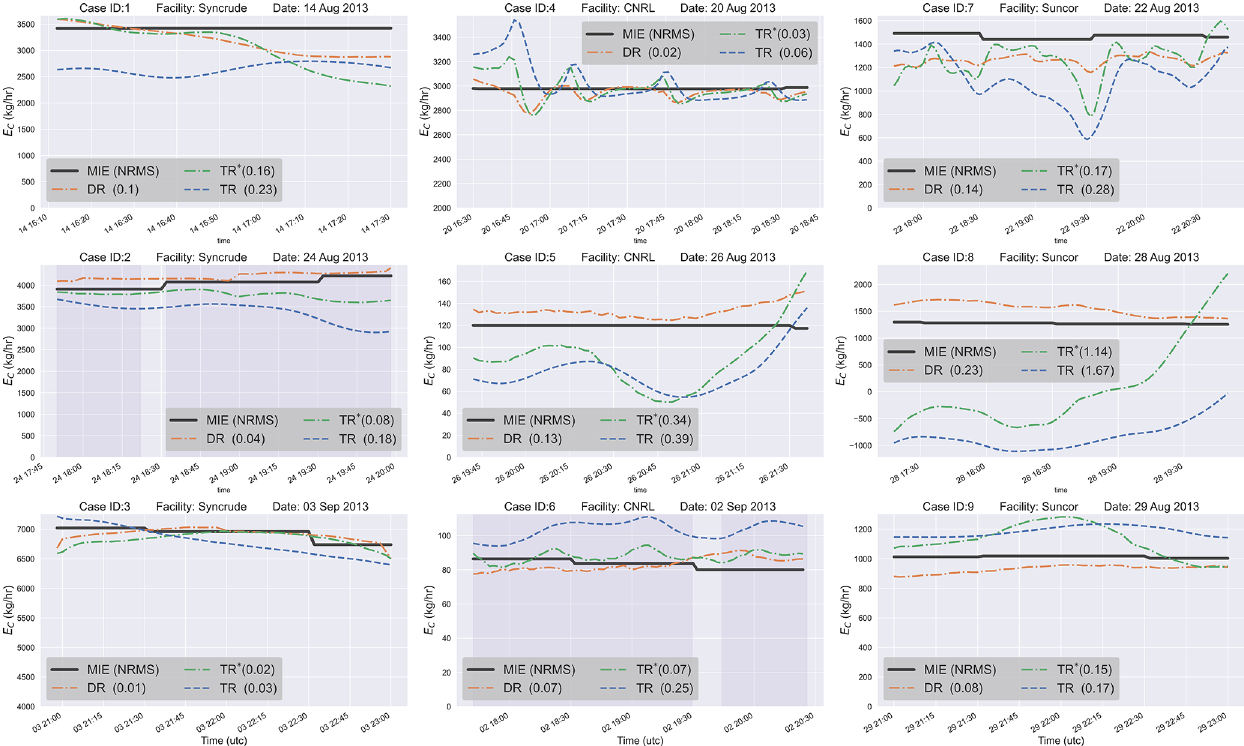
Figure 5. Time series of the estimates by DR, TR and TR ∗ methods, plotted along with MIEs. Normalized-root-mean-square (NRMS) error for the three methods are noted on the plot for each of the nine JOSM 2013 cases. JOSM 2013 flights on 24 August (case 2) and 2 September (case 6) included two consecutive box flights around the same facility, shown as shaded areas on their respective time-series plots. Note that the DR and TR ∗ methods, unlike the TR method, account for the storage rate ( E C , S and E tr